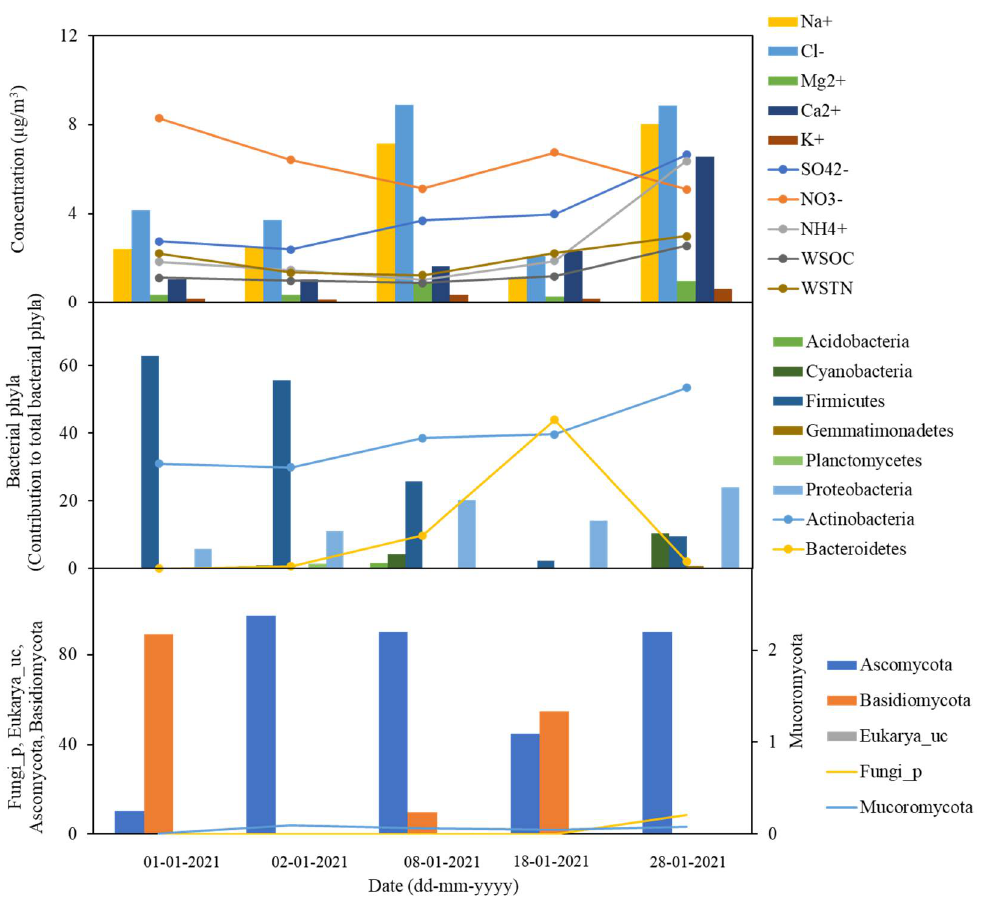
Figure 6. Temporal variation in the chemical composition ( µ g m − 3 ), bacterial phyla, and fungal phyla in the fresh snowfall samples of Daejeon, the Republic of Korea.